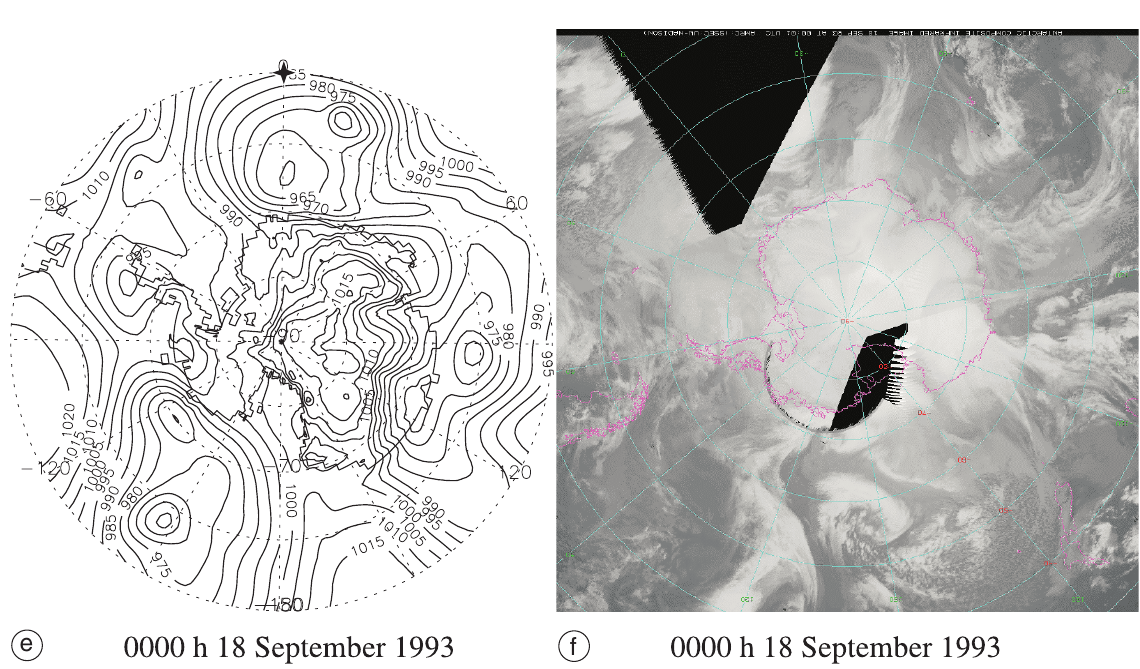
Fig. 9e,f. ECMWF analysis of mean sea level pressure chart and composite infrared satellite image for 0000 h 18 September 1993.